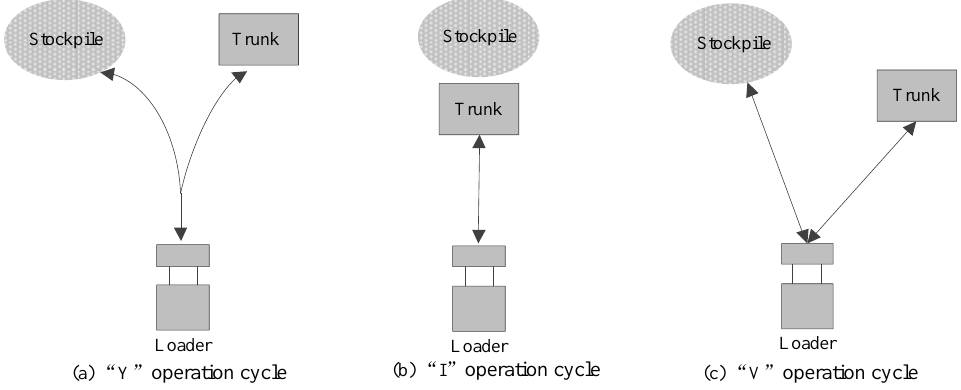
Figure 2. Typical operation cycle schematic diagram of a loader.